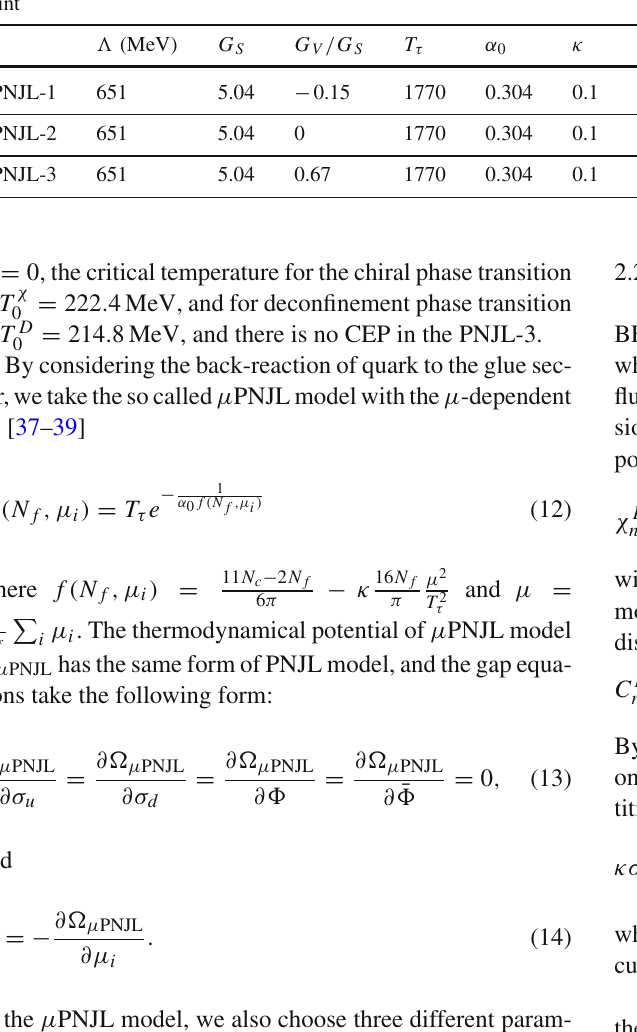
Table 2 Three sets of parameters used in the PNJL model, and the corresponding critical temperatures and chemical potentials at the critical end point